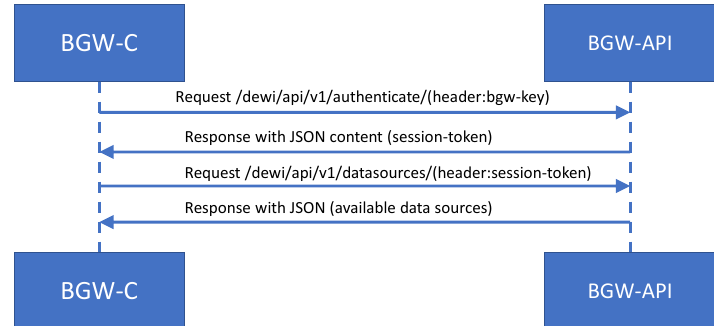
Figure 15. Example of the DEWI L2 technology call model.